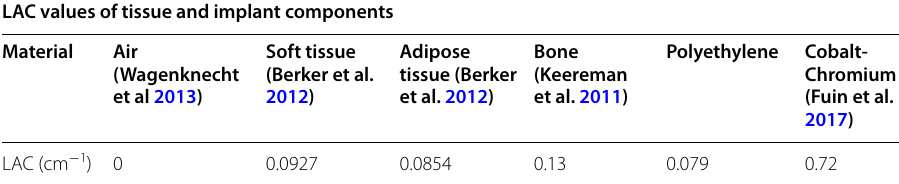
Values were derived from literature or CT-based density calculation